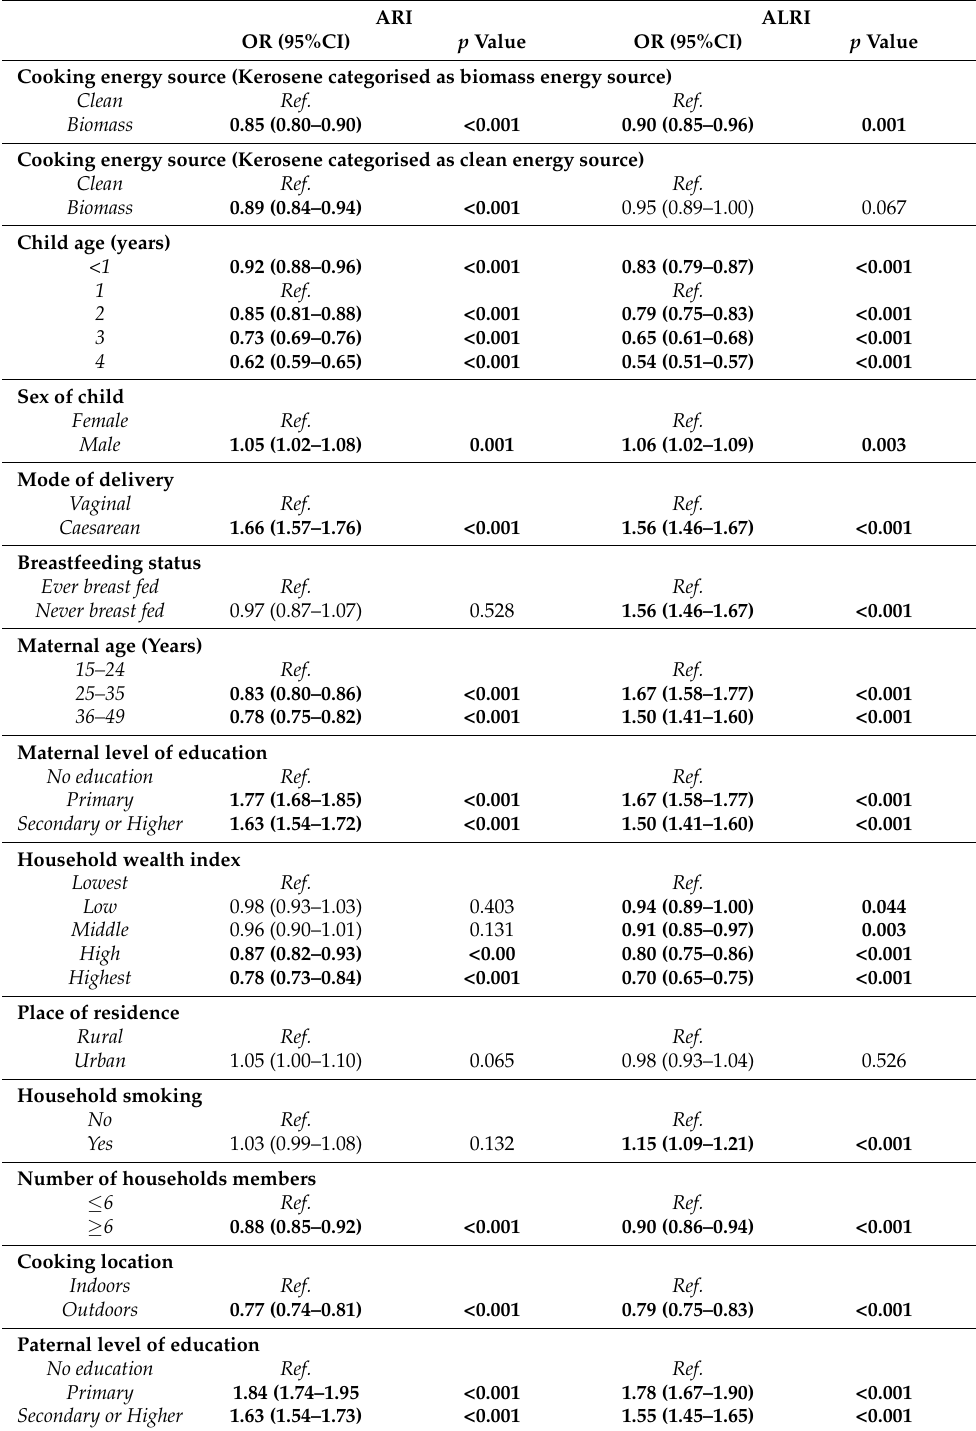
Table A1. Unadjusted odds ratio (OR) with 95% CI for the association of ARI and ALRI in children aged under five years with biomass cooking compared to cleaner